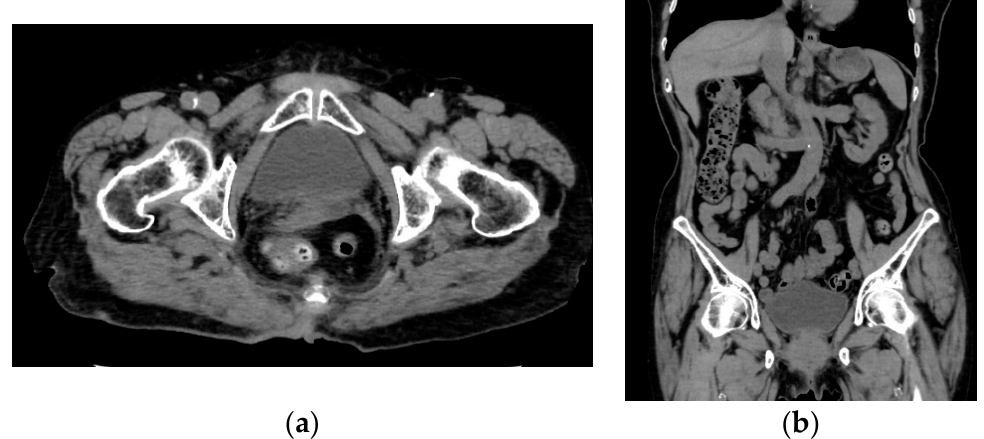
Figure 5. Computed tomography showing reduced recurrent lesions of ( a ) the vaginal stump and ( b ) the para-aortic lymph node. ( b ) the para-aortic lymph node.